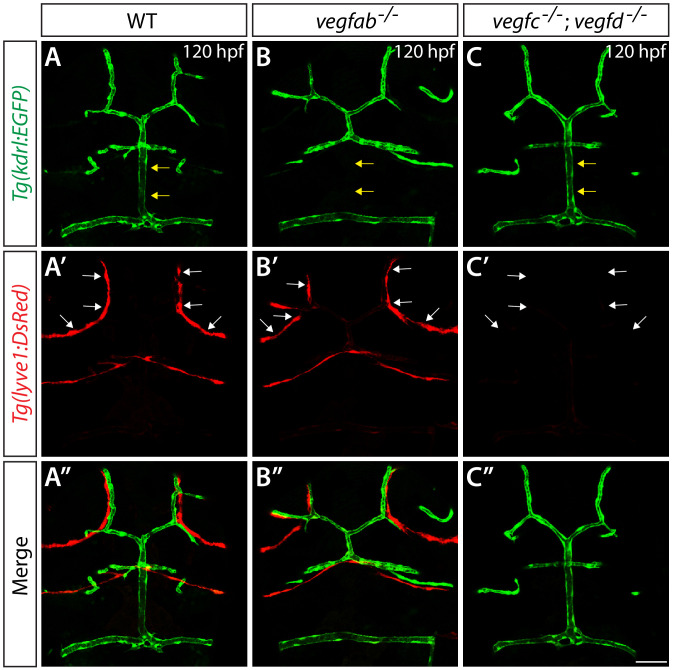
Developmental relationships between FGPs and mCP vasculature in WT, vegfab-/-, and vegfc-/-;vegfd-/- larvae.(A–C") Dorsal views of 120 hpf WT (A–A"), vegfab-/- (B–B"), and vegfc-/-;vegfd-/- (C–C") heads of larvae that carried the Tg(kdrl:EGFP) (A–C) and Tg(lyve1:DsRed) (A’–C’) transgenes (merged images shown in A"–C"). All of the vegfab-/- larvae that lacked the DLV (n = 7) formed FGPs in the dorsal surfaces of the brain meninges (B–B"), as observed in WT larvae (n = 13). In contrast, vegfc-/-;vegfd-/- larvae (C–C") that exhibited the complete loss of FGPs (n = 9) formed the DLV and PCeV, as observed in WT fish. Yellow arrows point to the DLV and white arrows to the FGPs. Scale bar: 50 µm.